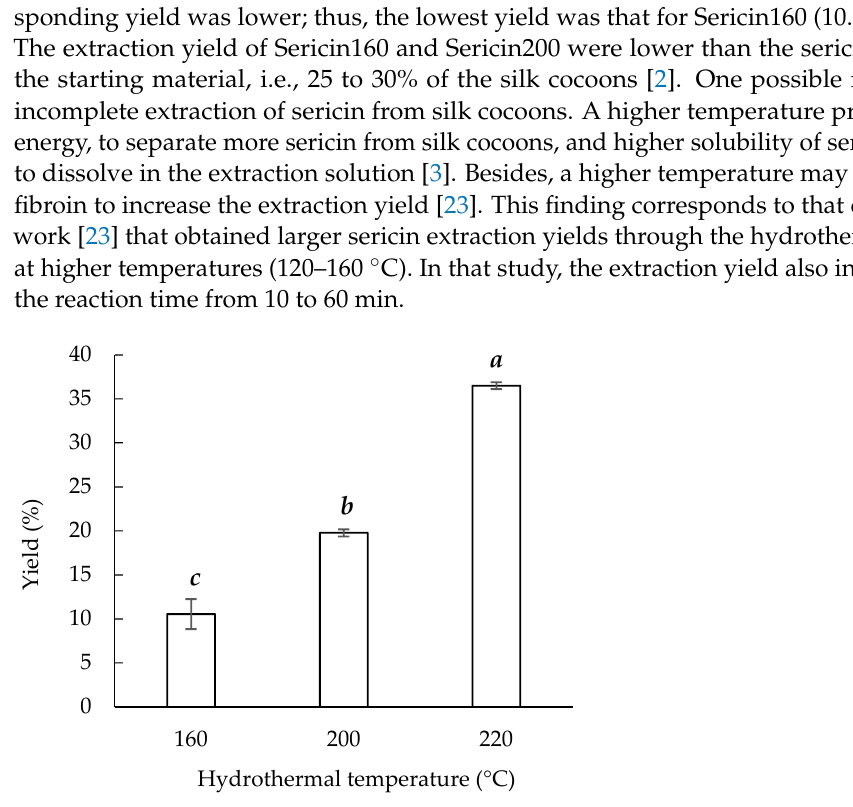
Figure 1. Hydrothermal extraction yields at various temperatures. Means with the same lowercase letters are not significantly different, per LSD test results.